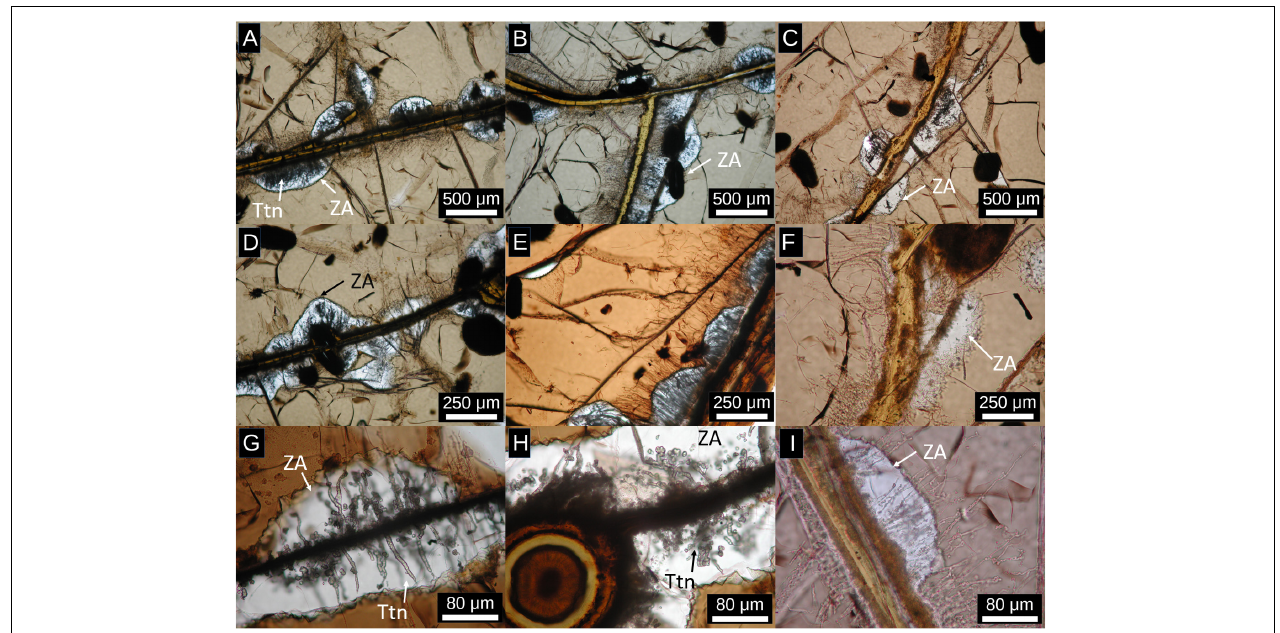
FIGURE 3 | Transmitted light photomicrographs at a variety of scales showing tubules within regions of zeolitic alteration (white, ZA). (A–C) 20 × magnification, (D–F) 40 × magnification, (G–I) 80 × magnification. Primary tubules within glass are mostly hollow, while within the zeolitic alteration, they are overprinted by fine-grained titanite (high relief, gray–white, Ttn). Zeolite alteration typically nucleates along fracture surfaces and expands into the glass (pale brown), forming smoothly curved interfaces with glass. Zeolite alteration is commonly, but not exclusively, centered on regions with high tube densities, suggesting that high tube densities enhance fluid access to the glass. Also visible are regions of palagonite variably stained by Fe-oxyhydroxides, such as the concentric rounded object in panel (H)